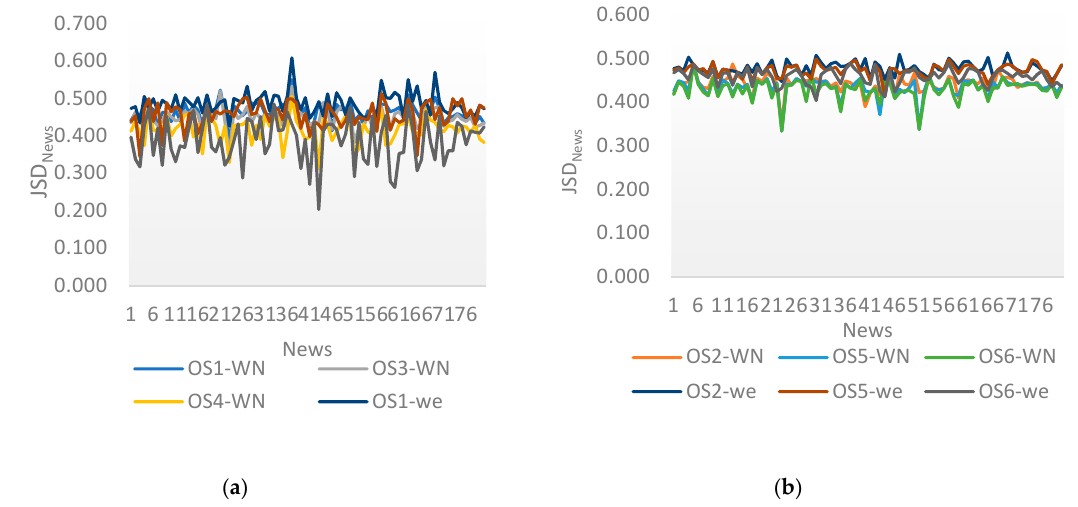
Figure 6. Results of JSD News (Jensen–Shannon divergence focused on the news) applying ( a ) term and ( b ) sentence clustering, using WordNet and word embeddings on the TelecomServ dataset.